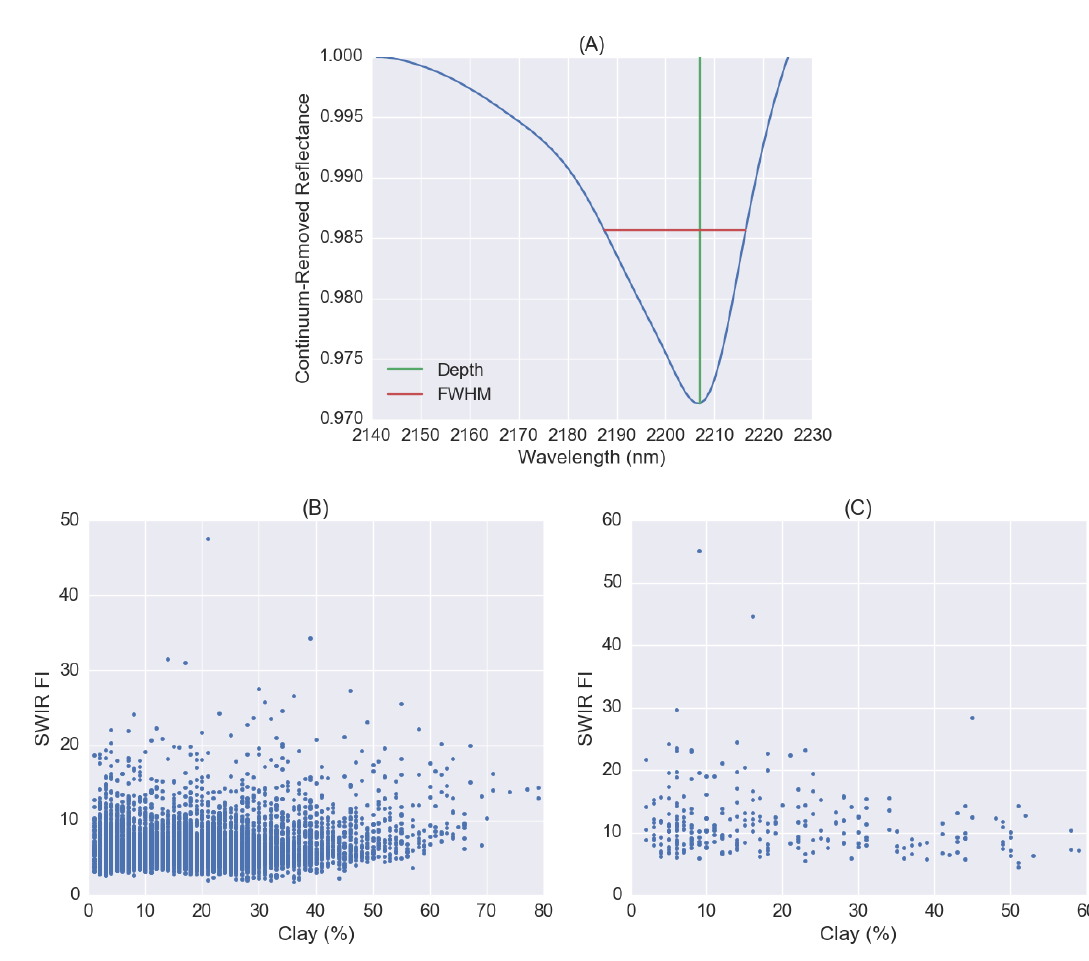
Figure 7. Absorption feature near 2200 nm for the mean spectrum of mineral soils ( A ), and scatter plots between soil clay contents and the corresponding short-wave infrared fine particle index (SWIR FI) values for mineral ( B ), and organic soils ( C ).